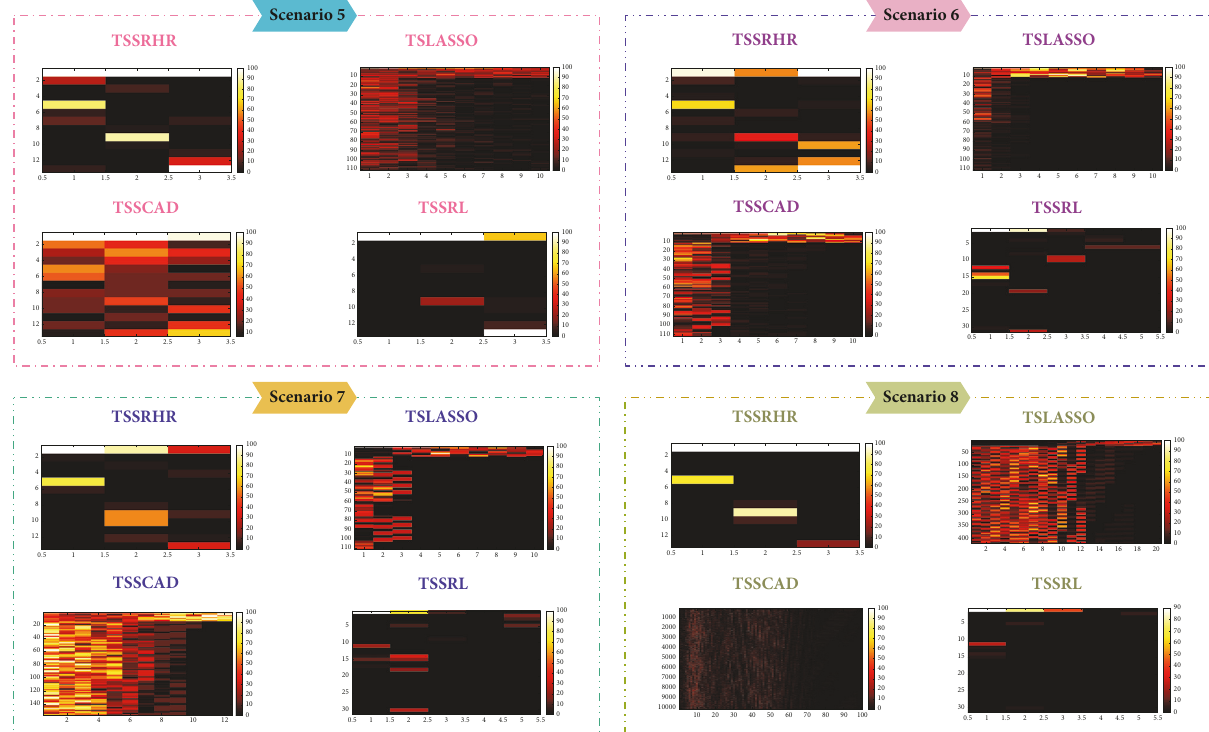
Figure 3: Sparsity pattern of compared forecasting methods in Scenarios